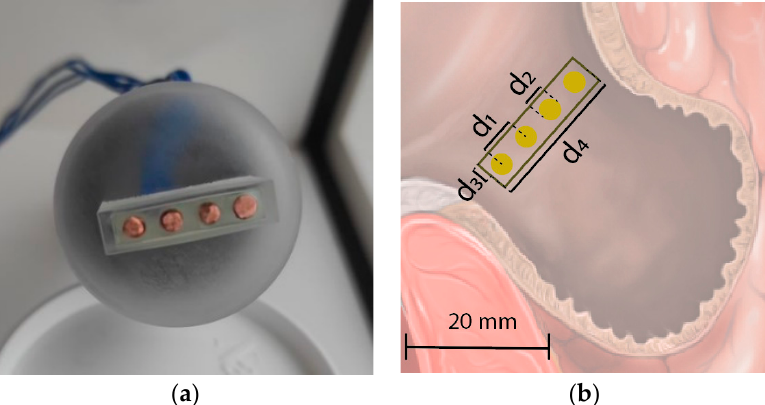
Figure 2. ( a ) Photo of the manufactured prototype of the proposed tetrapolar collinear probe; ( b ) Diagram showing the dimensions of the used tetrapolar collinear probe. The illustration shows the footprint of the probe on the surface of the LAA.